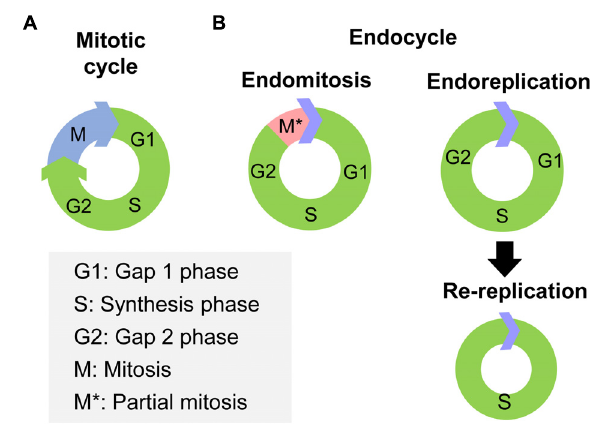
FIGURE 1 | The processes of mitotic cycle and endocycle. (A) The mitotic cycle comprises Gap 1 phase (G1), synthesis phase (S), Gap 2 phase (G2), and mitosis (M) phase. (B) The endocycle have two variations, endomitosis and endoreplication. Endomitosis consists of G1, S, and G2 phases and only a partial M phase. Endoreplication consists of repeated successions of S to G phase that completely skips mitosis phase. Re-replication is a special type of endoreplication, in which DNA replication is initiated multiple times at individual origin of replication within the same S